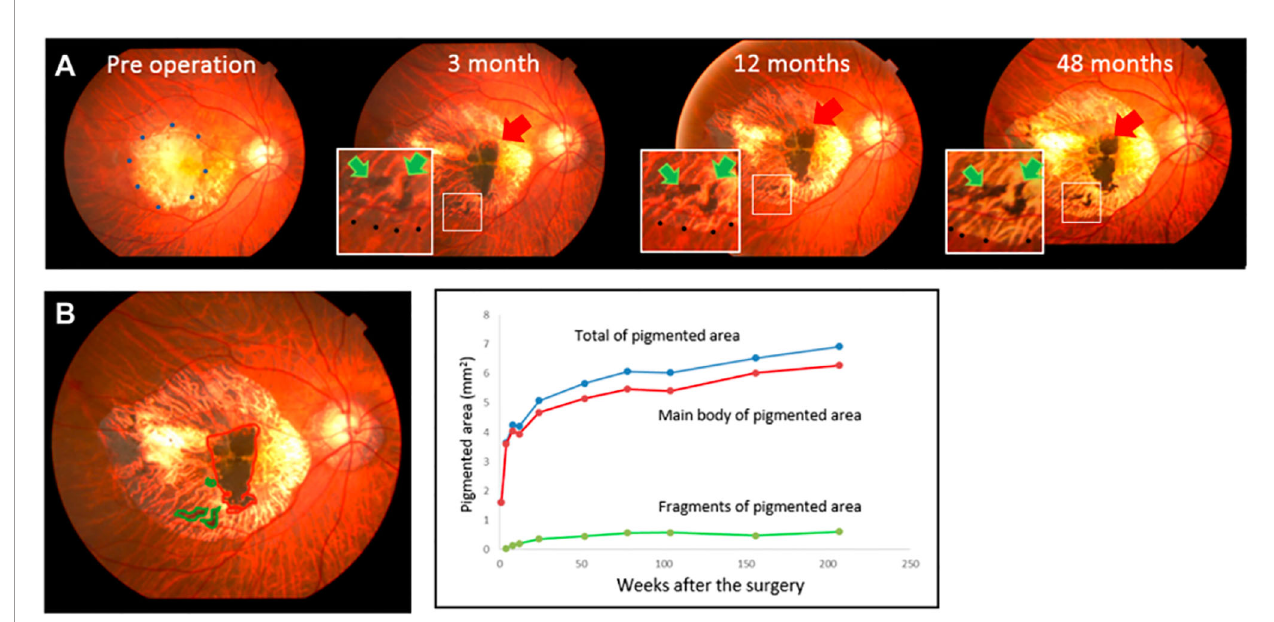
FIGURE 2 | Photographic fundus images over four years following transplant of sheet of autologous iPSC-RPE. (A) Red arrows point to the main graft while green arrows indicate islands of graft cells. (B) The graft area, identi fi ed by the presence of pigmentation, was calculated using ImageJ. Areas of the main graft and islands of grafted cells were plotted over 4 years. Expansion of pigmented area is exhibited in relatively homogenous distribution without clumping or signs of in fl ammation. Reprinted from Takagi 2019, license number